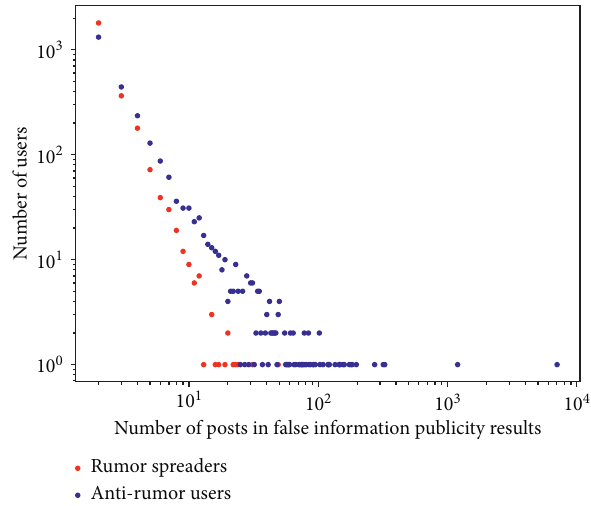
Figure 4: Distributions of posts in false information publicity